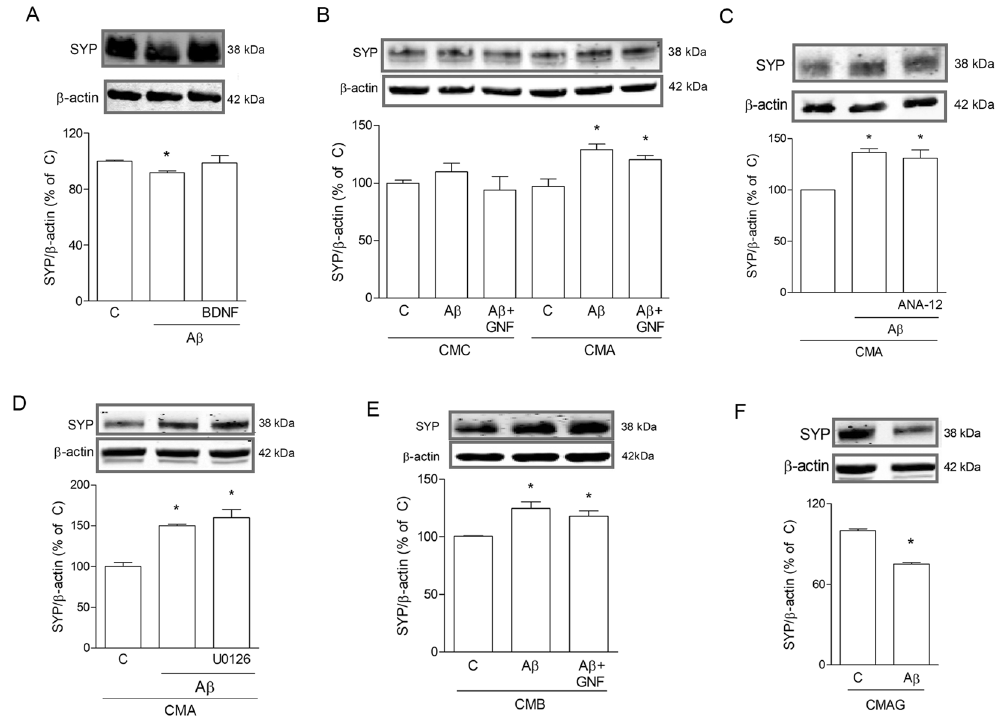
Figure 3. CM from microglia prevents A β 42-driven SYP loss. Western blot analysis of SYP in SH-SY5Y cells exposed for 5 h to A β 42 (0.5 μ M) in different conditions. In A, cells were treated with A β 42 alone or in combination with BDNF in non-conditioned medium ( A ). In ( B ), cells were exposed to A β 42 alone or in combination with GNF5837 (GNF) in CM from untreated pMG (CMC) or from pMG treated with A